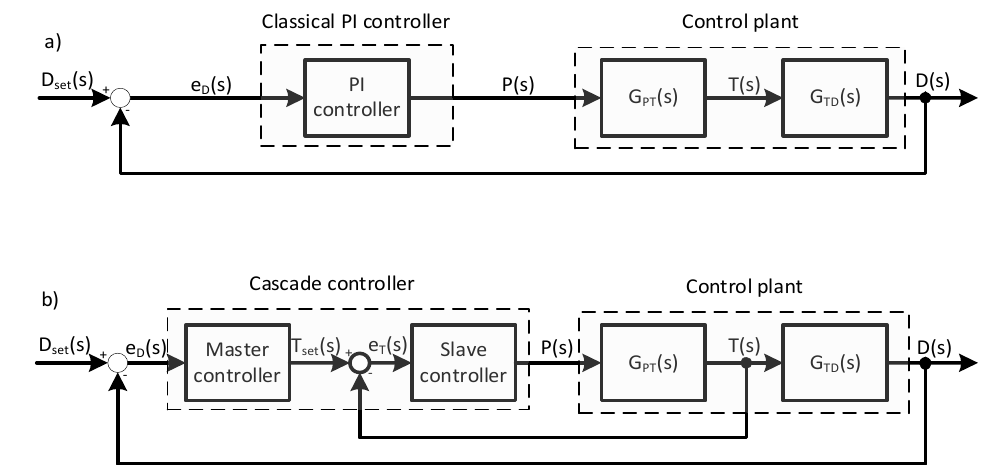
Figure 24. Analyzed systems for controlling the dryness of cotton tape, using a classic PI controller ( a ) and a cascade controller ( b ), where D set is the dryness setpoint value, e D is the dryness control error, P is the heating power, T is the surface temperature of the cylinder, D is the dryness of the cotton tape, T set is the value set for the surface temperature of the cylinder, and e T is the surface temperature control error.